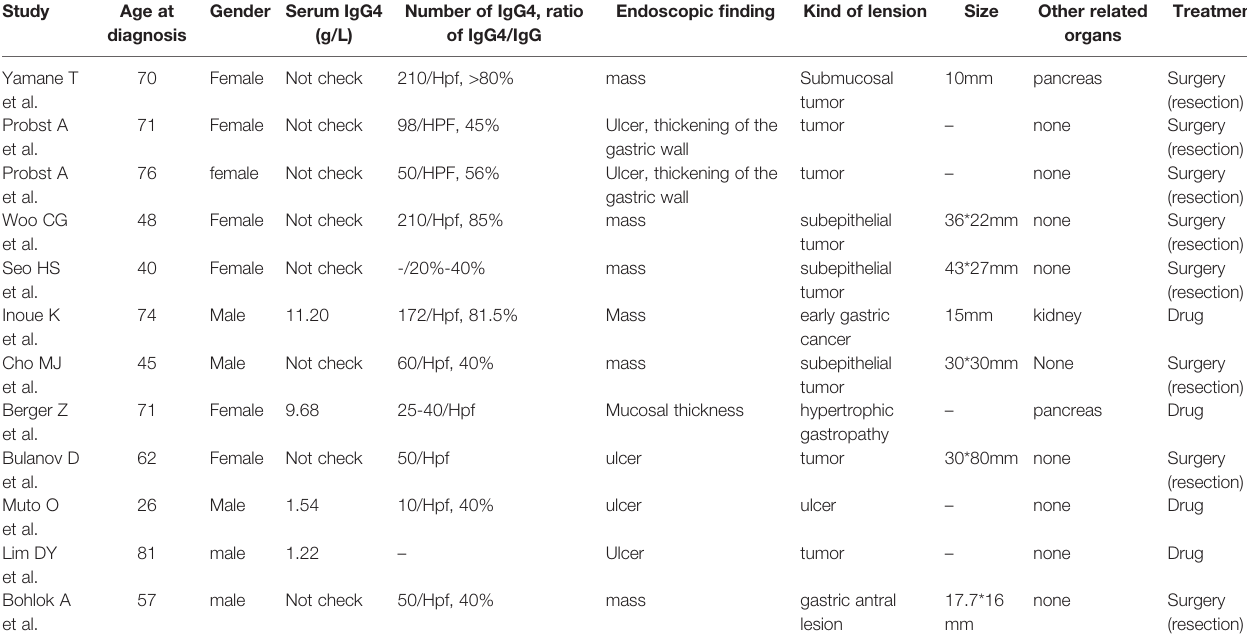
TABLE 1 | Cases of IgG4-related gastric